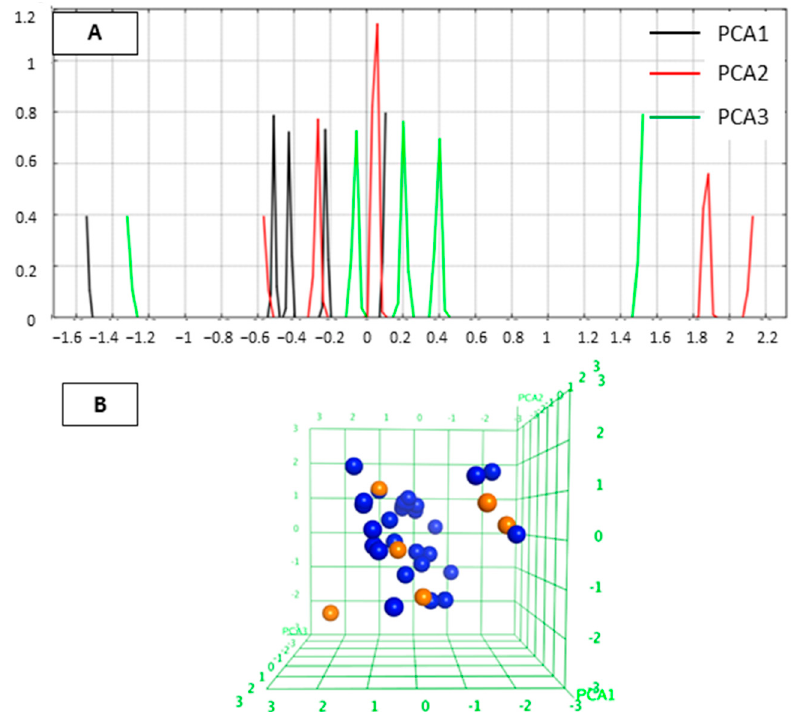
Figure 9. ( A ) 2D plots for visualization of the variation of three most important PCA in test set. Black color represents PCA1, red color PCA2 and green color PCA3. ( B ) 3D plot of the chemical space occupied by the training set (blue) and test set (orange).